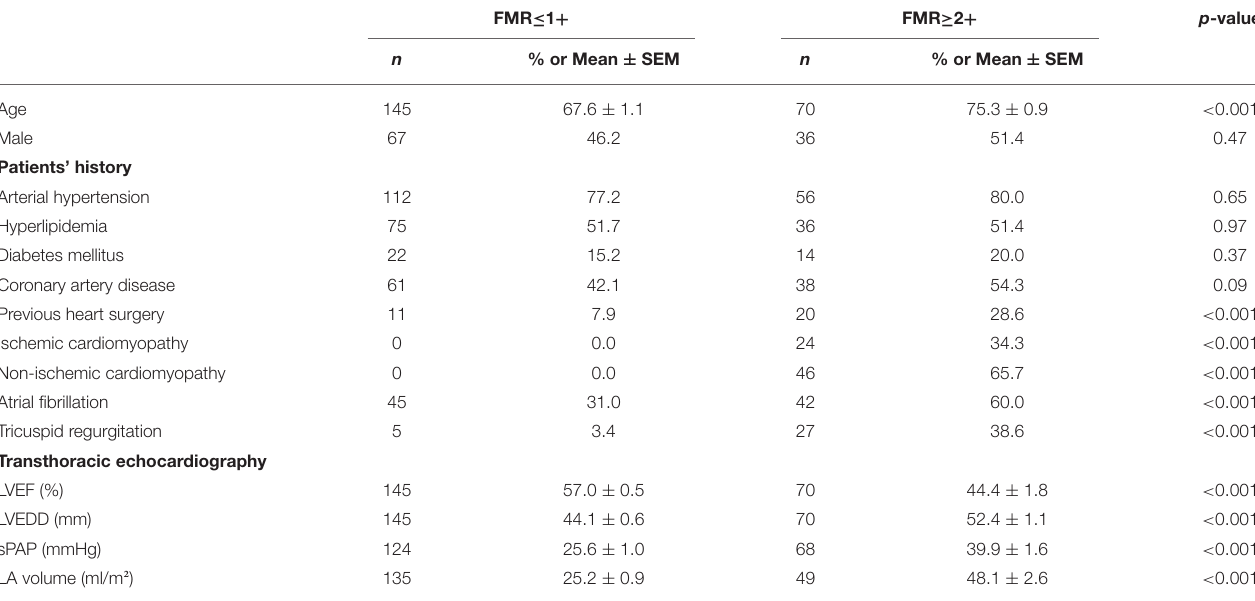
TABLE 1 | Patients